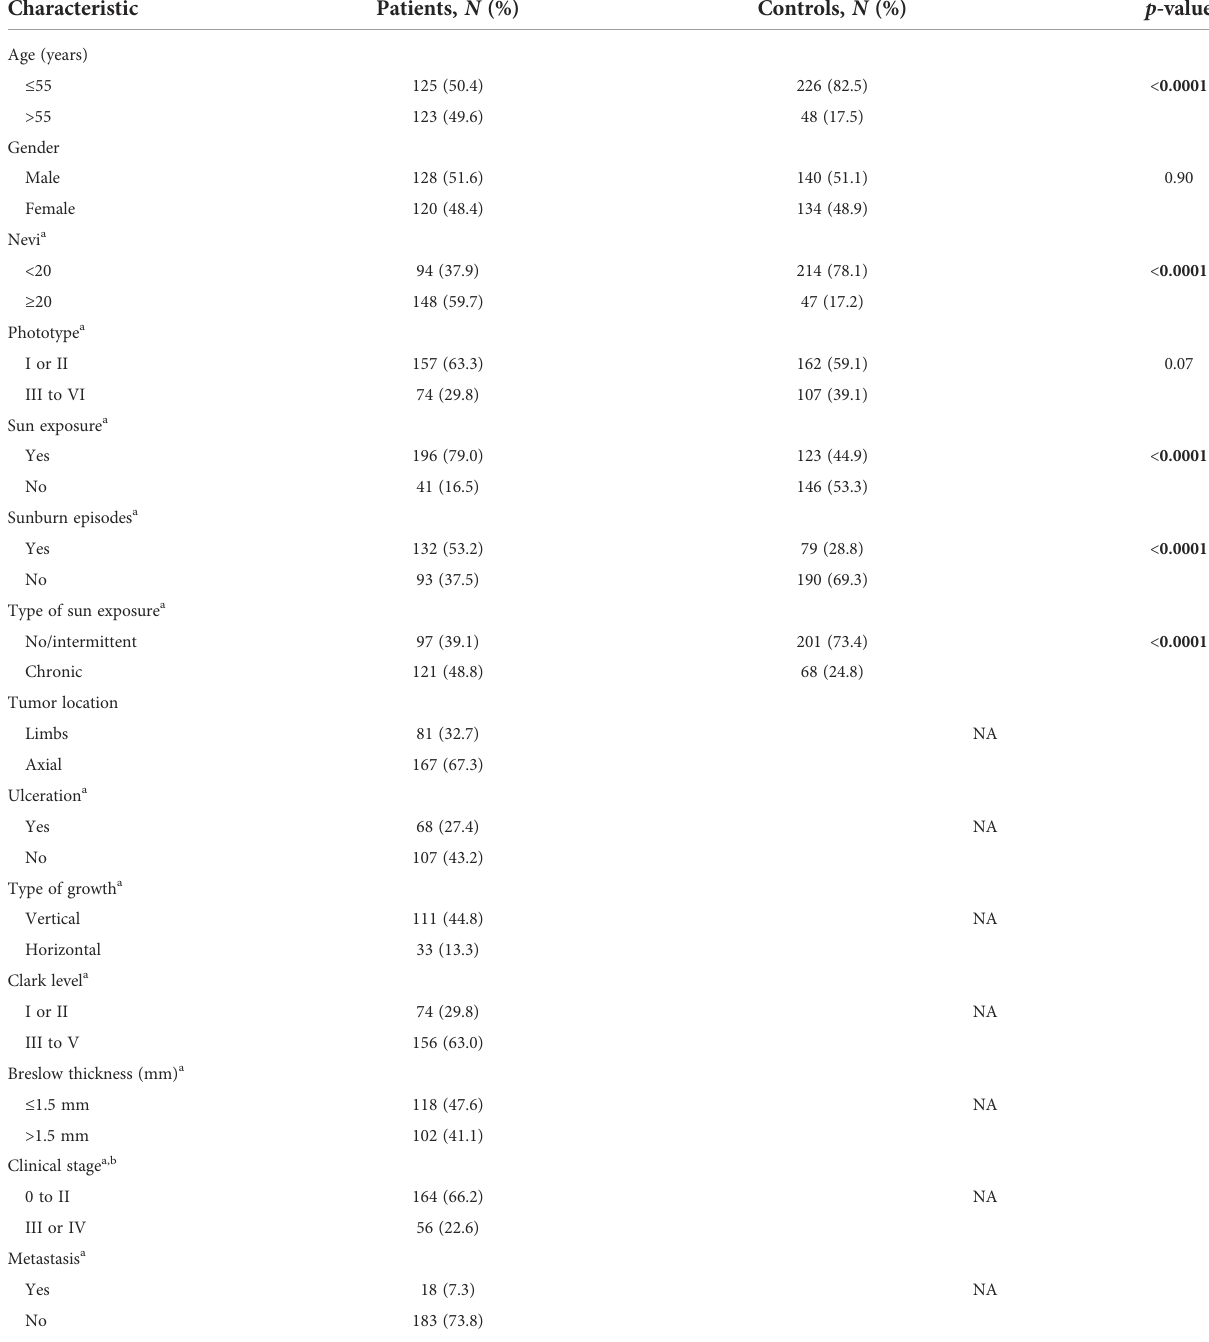
TABLE 1 Distribution of 248 cutaneous melanoma patients and 274 controls strati fi ed by clinicopathological aspects. Characteristic Patients, N